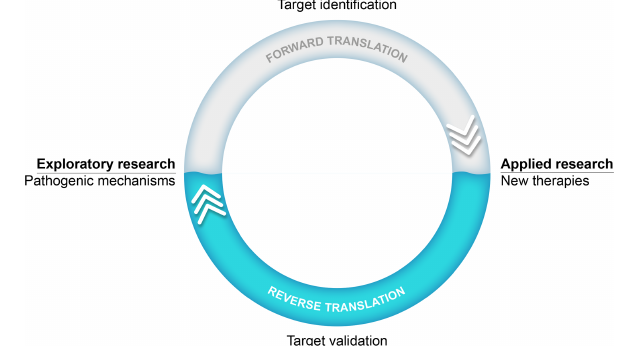
Figure 1. Translational research: an iterative process. The main goal of our exploratory preclinical research has been to find new targets in the pathogenic process for safer and more effective ther- apies. The translation of a new scientific discovery into a safe and effective innovative treatment for patients is indicated as forward translation. In the applied arm of our research, new therapies are tested. Results from such tests can be used to validate scientific con- cepts. When the process of forward translation fails, the reasons for failure should be investigated and this information should be fed back (i.e., reverse translation) to the animal model in order to make the necessary corrections in the scientific concept and/or the animal model